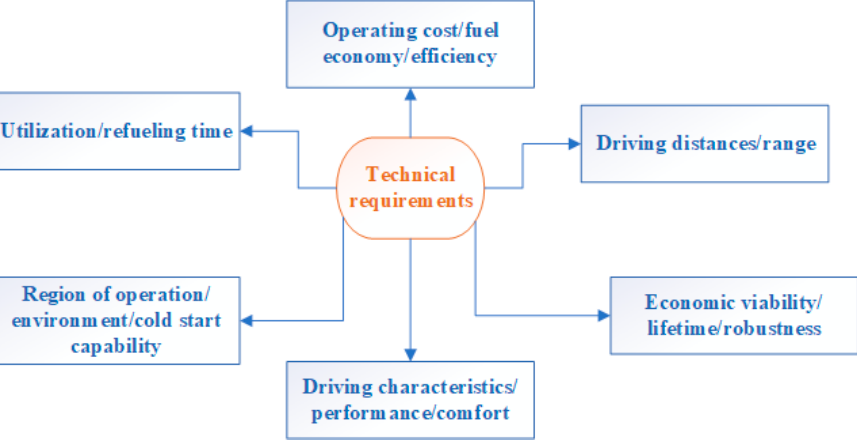
Figure 1. Technical requirements of fuel cell vehicle.